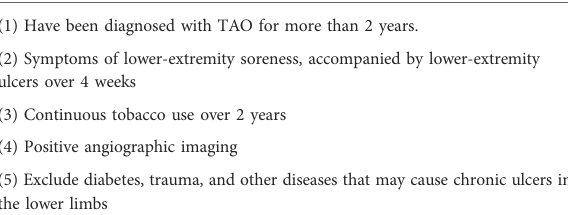
TABLE 1 Inclusion criteria for improved tibial cortex transverse transport. Inclusion criteria